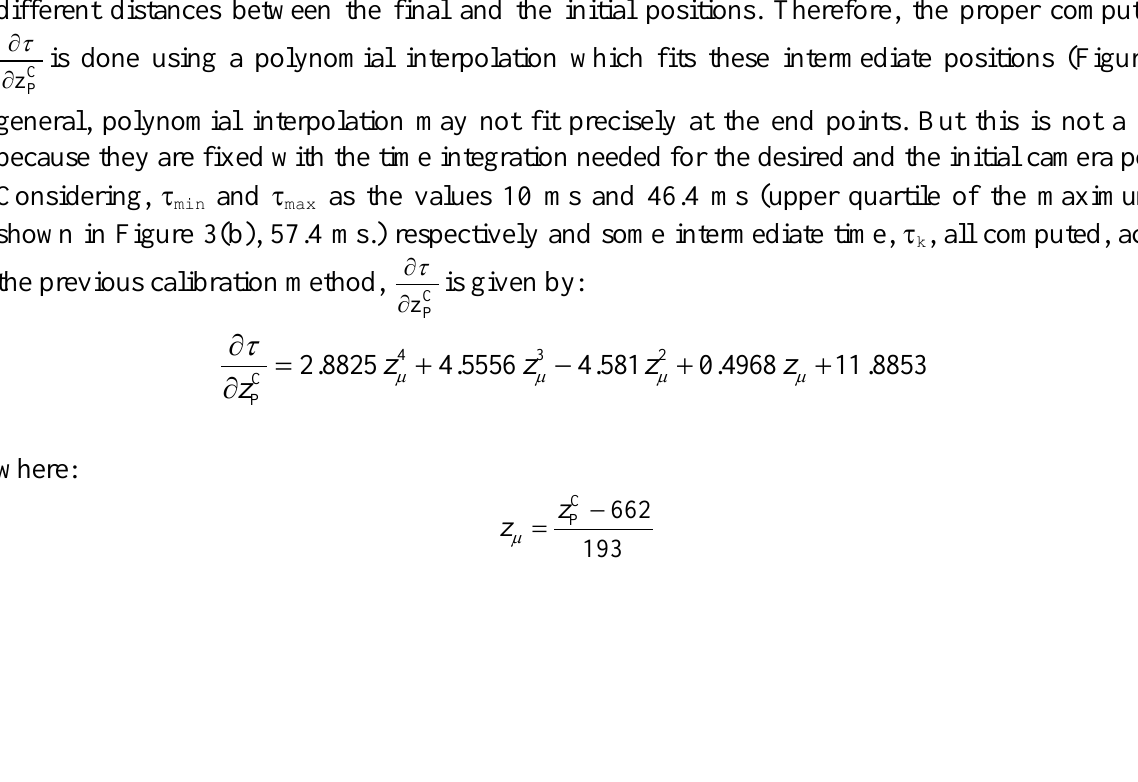
Figure 3. Evolution of mean amplitude, a